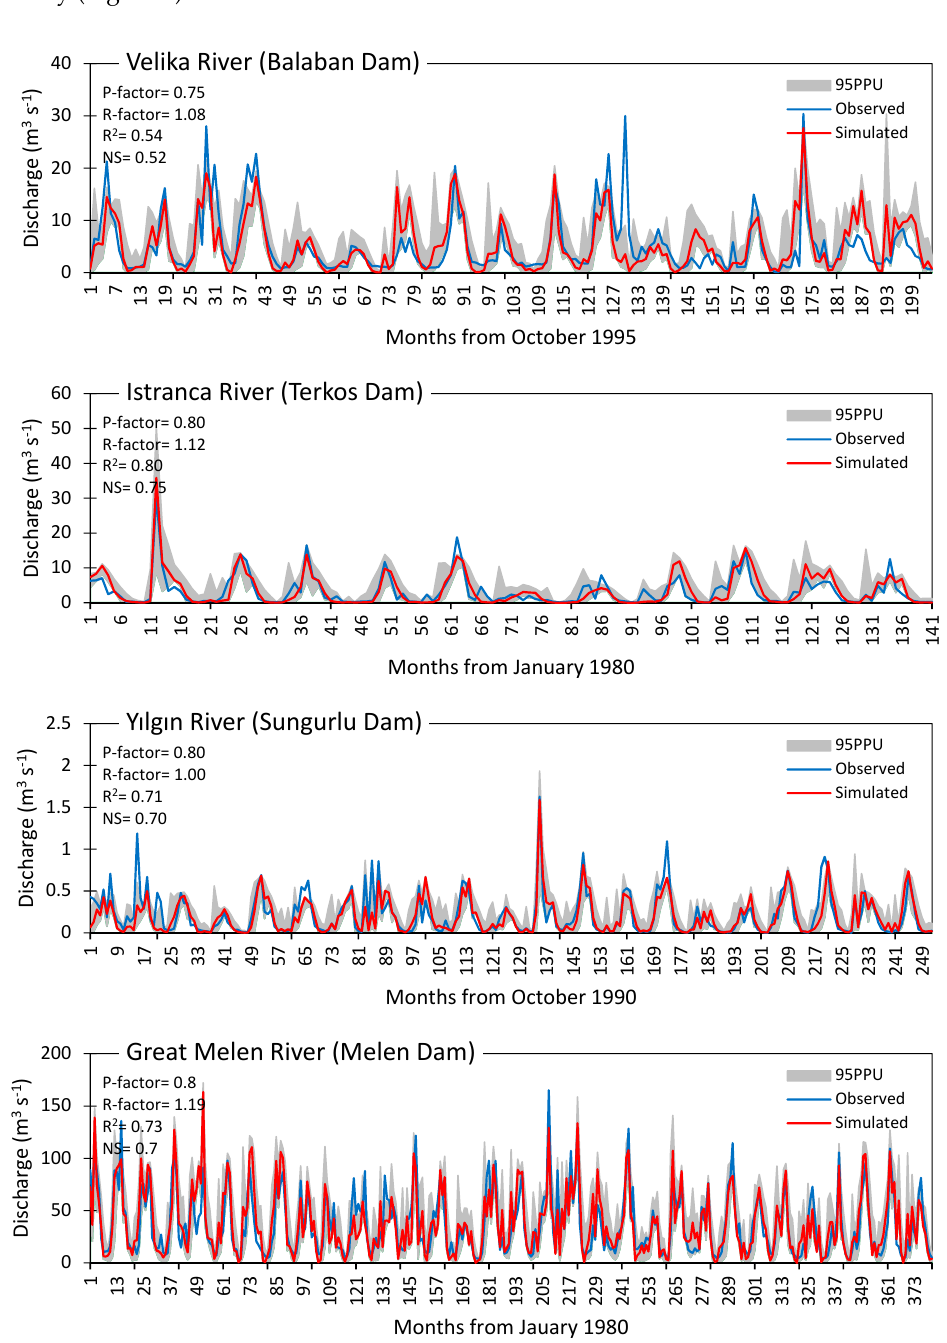
Figure 8. Illustration of the SWAT-CUP output for the simulation period depicting the observed, simulated and 95% prediction uncertainty (95PPU). These hydrographs belong to gauge station Nos. 50, 243, 542 and 835, respectively.